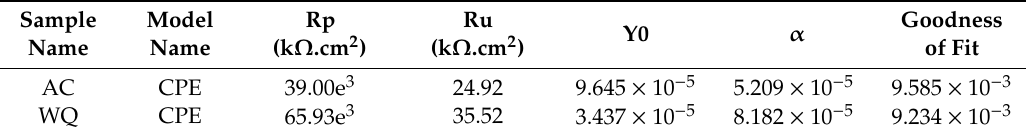
Figure 6. Equivalent circuit model (ECM) employed to fit the impedance data.